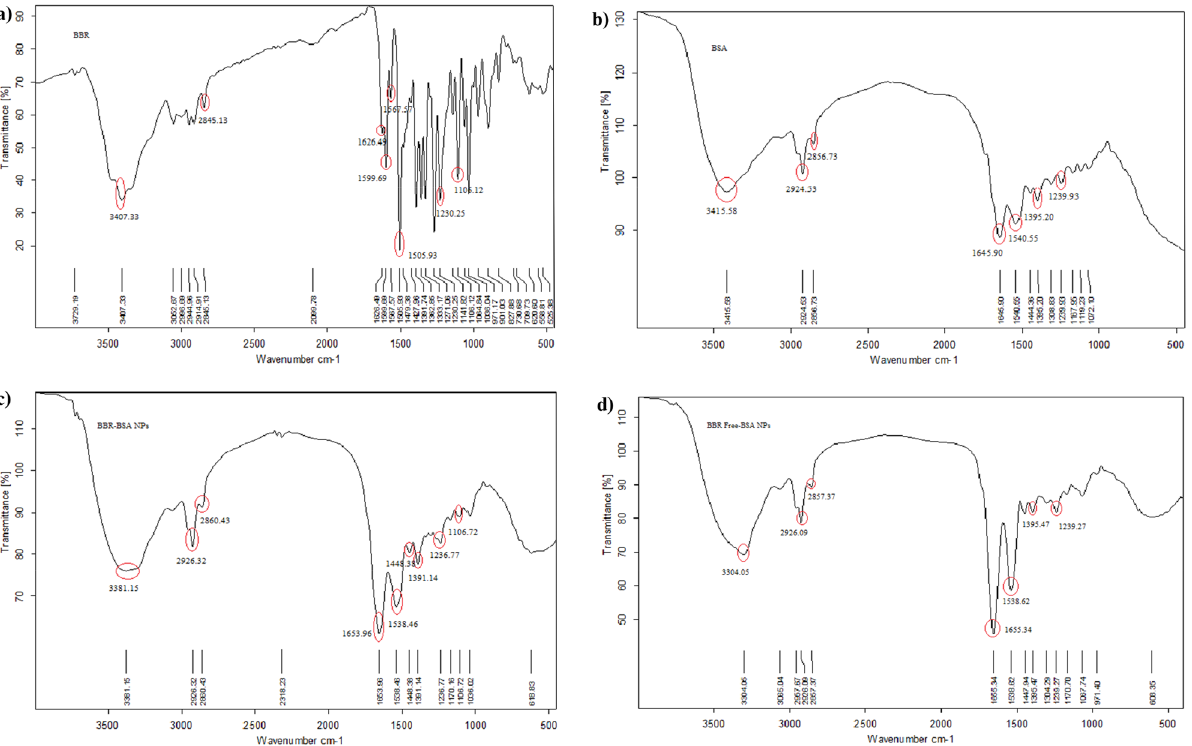
Figure 2. The FTIR characteristic spectra of standard BBR-chloride ( a ), crystalline BSA ( b ), BBR-BSA NPs ( c ), and BSA NPs ( d